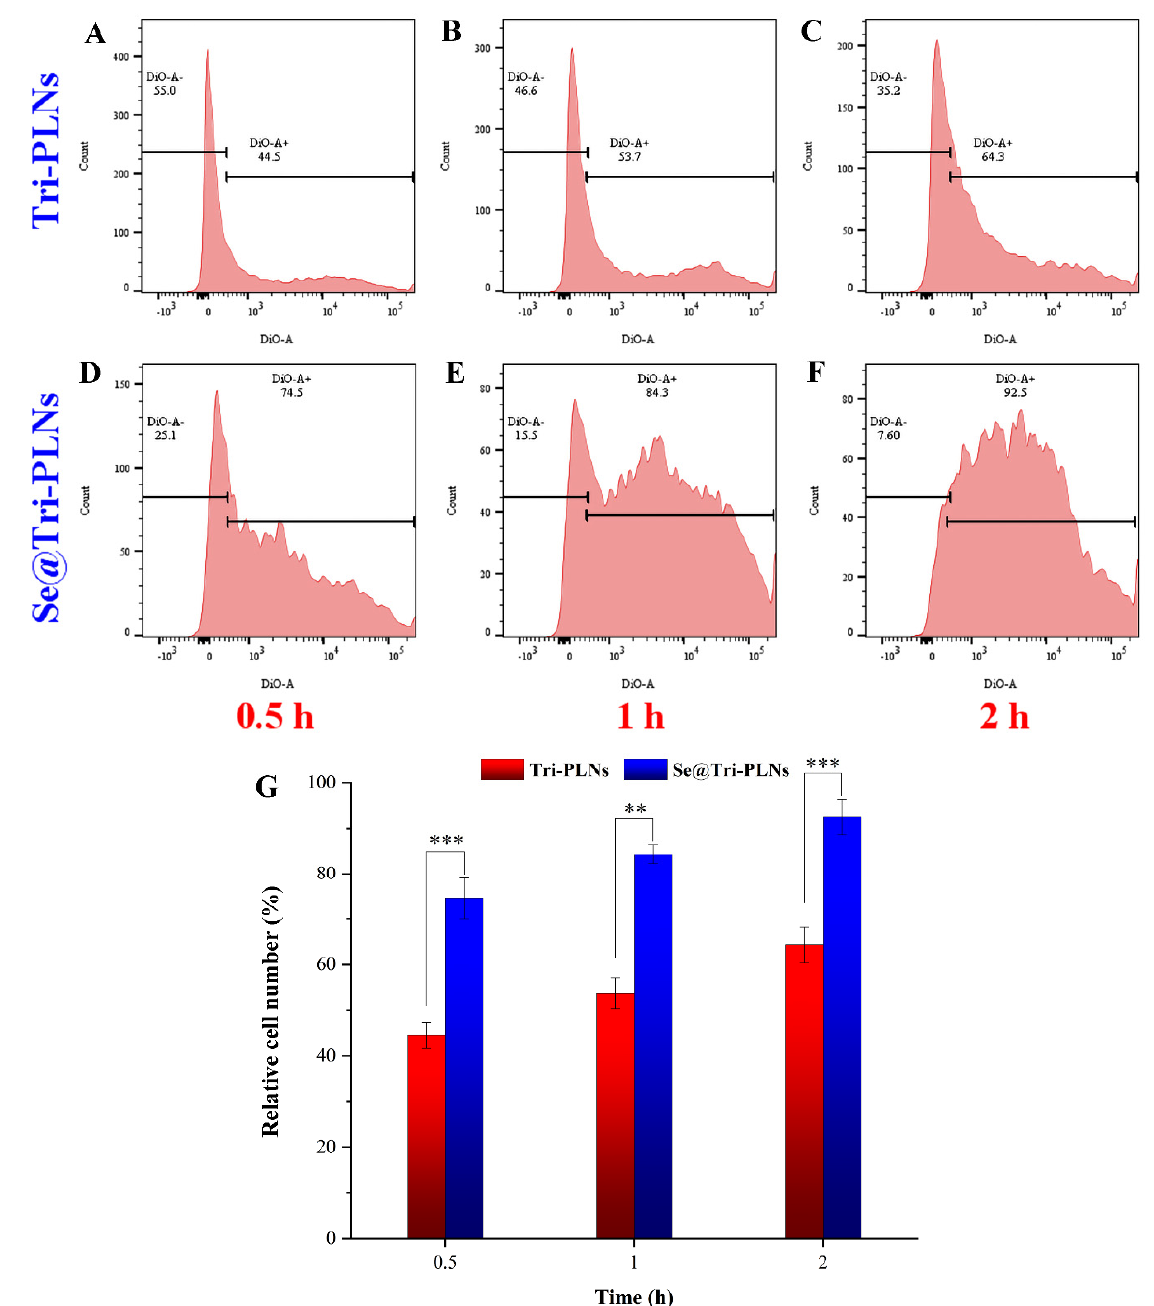
Figure 7. Cellular uptake of Tri ‐ PLNs and Se@Tri ‐ PLNs quantified by flow cytometry using fluorescently labeled nanoparticles after incubation with Caco ‐ 2 cells for 0.5, 1, and 2 h. ( A – F ): statistical distribution diagrams of positive cells; ( G ): histograms of relative positive cells. Data expressed as mean ± SD ( n = 3), paired t ‐ test, ** p < 0.01, *** p < 0.001.